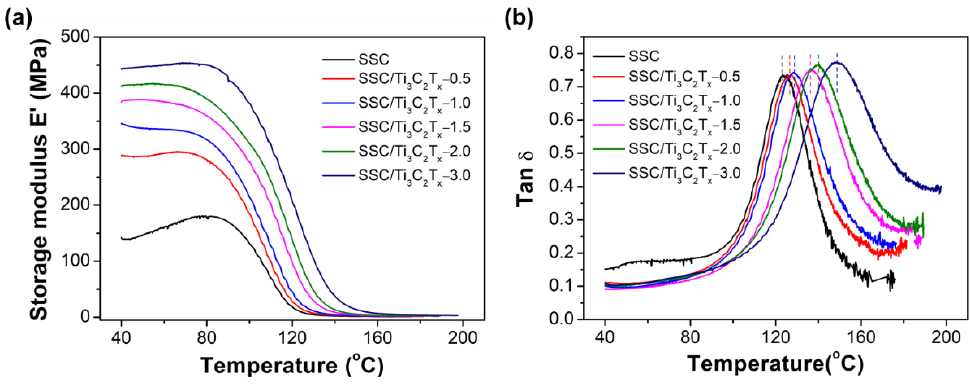
Figure 8. ( a ) Storage modulus and ( b ) tan δ curves of the membranes measured by dynamic me- chanical analyzer